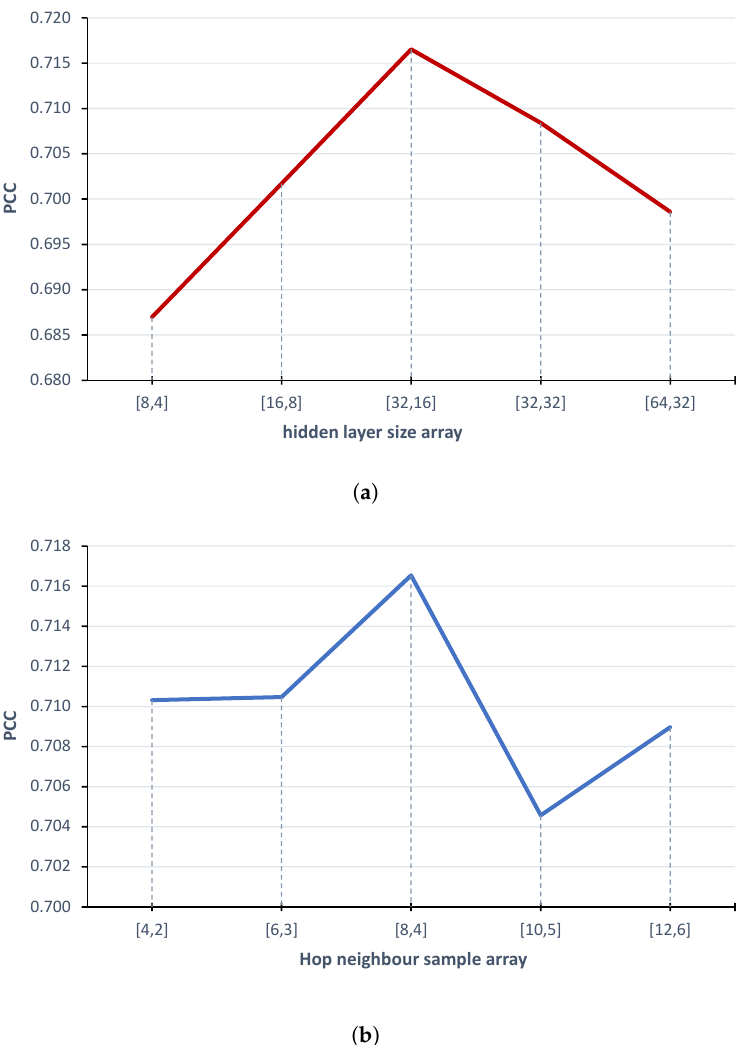
Figure 1. Fine-tuning of ( a ) HinSAGE hidden layers and ( b ) hop neighbour samples hyperparameters with respect to Pearson’s correlation